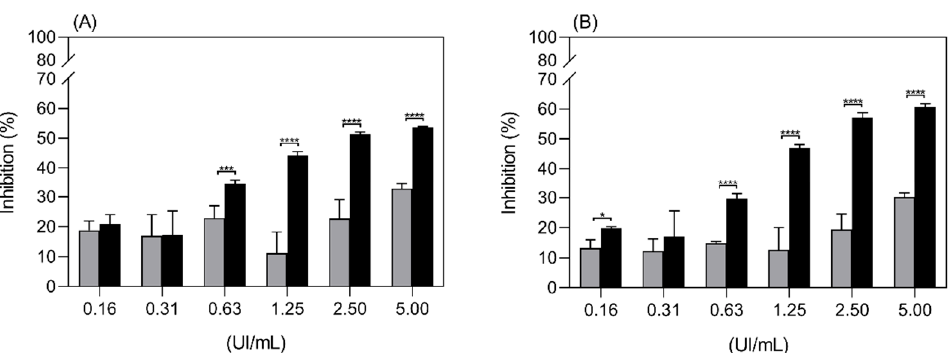
Figure 6. Inhibition of proliferation of the K562 cell line by ASP (grey bars) and Aginasa ® (black bars) in 48 h ( A ) and 72 h ( B ). Each point is the mean of six replicates, ± SD, from one representative experiment. * p -value < 0.5, *** p -value < 0.001 and **** p -value < 0.0001.